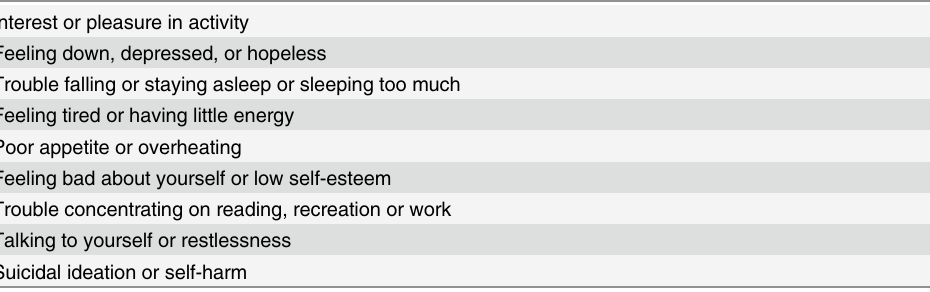
Table 2. Summary of PHQ-9